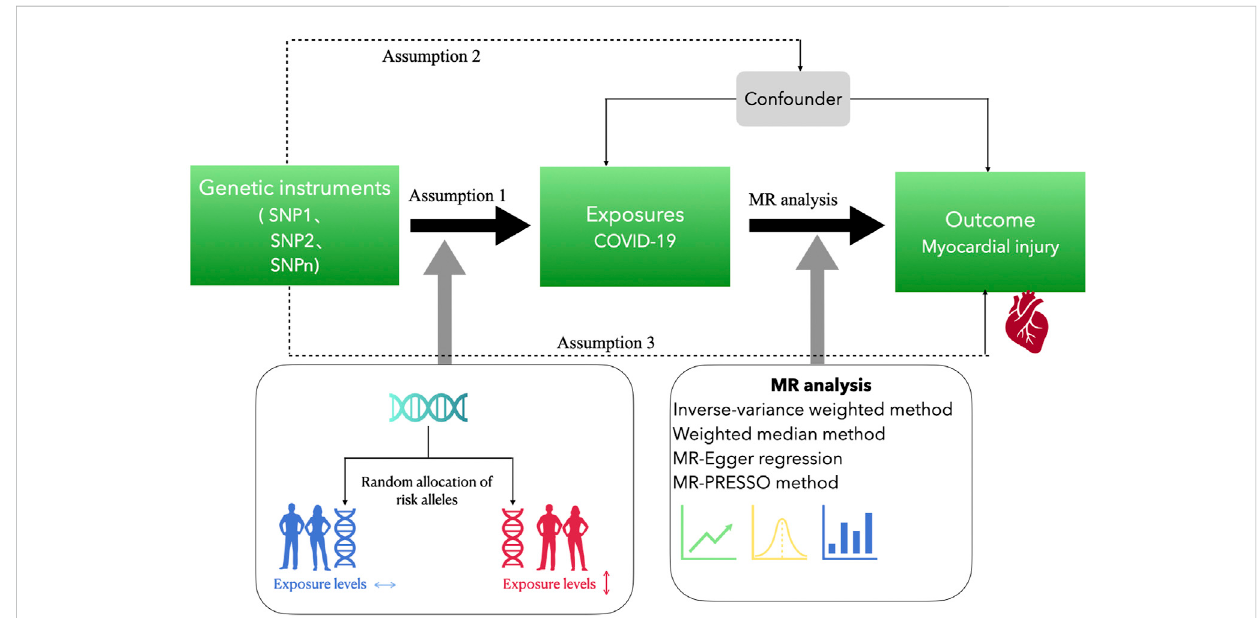
FIGURE 1 StudydesignoftheMendelianrandomizationstudy.Assumption1isthatthegeneticinstrumental variablesareassociatedwithexposure toCOVID- 19 and assumption 2 is that the genetic instrumental variables are not associated with the outcome via a confounding pathway. Assumption 3 is that the genetic instrumental variables do not affect the outcome directly, only possibly indirectly via the exposure. Assumption 1 is tested by statistical methods, such as p -value < 5 × 10 − 8 , F statistic > 10, inter-SNP linkage disequilibrium r 2 > 0.001, and clump distance = 10,000 kb. Assumption 2 is tested by using PhenoScanner. Assumption 3 is tested by genetic instrumental variables p > 5 × 10 − 8